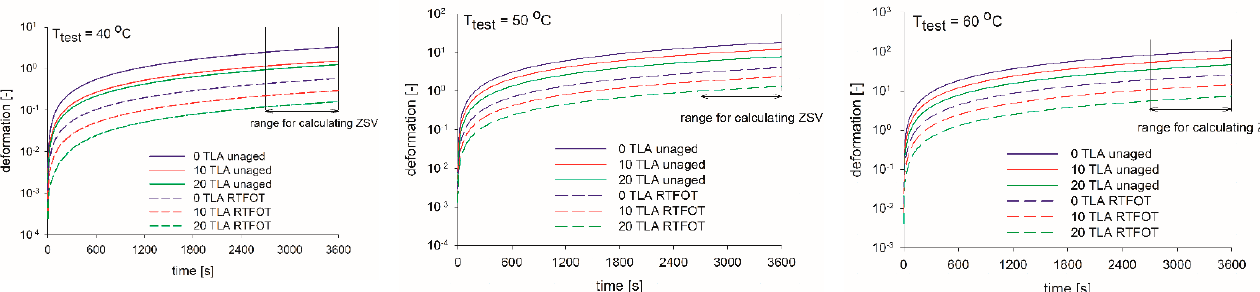
Figure 8. Creep curves for the TLA modified binders before and after aging at the specified test temperature.